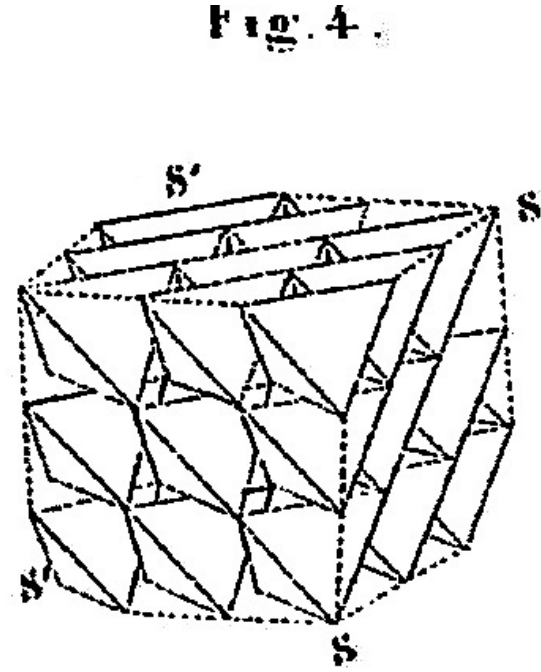
Figure 7. Model of boracite structure based on a framework of tet- rahedra as proposed by G. Delafosse. (From reference